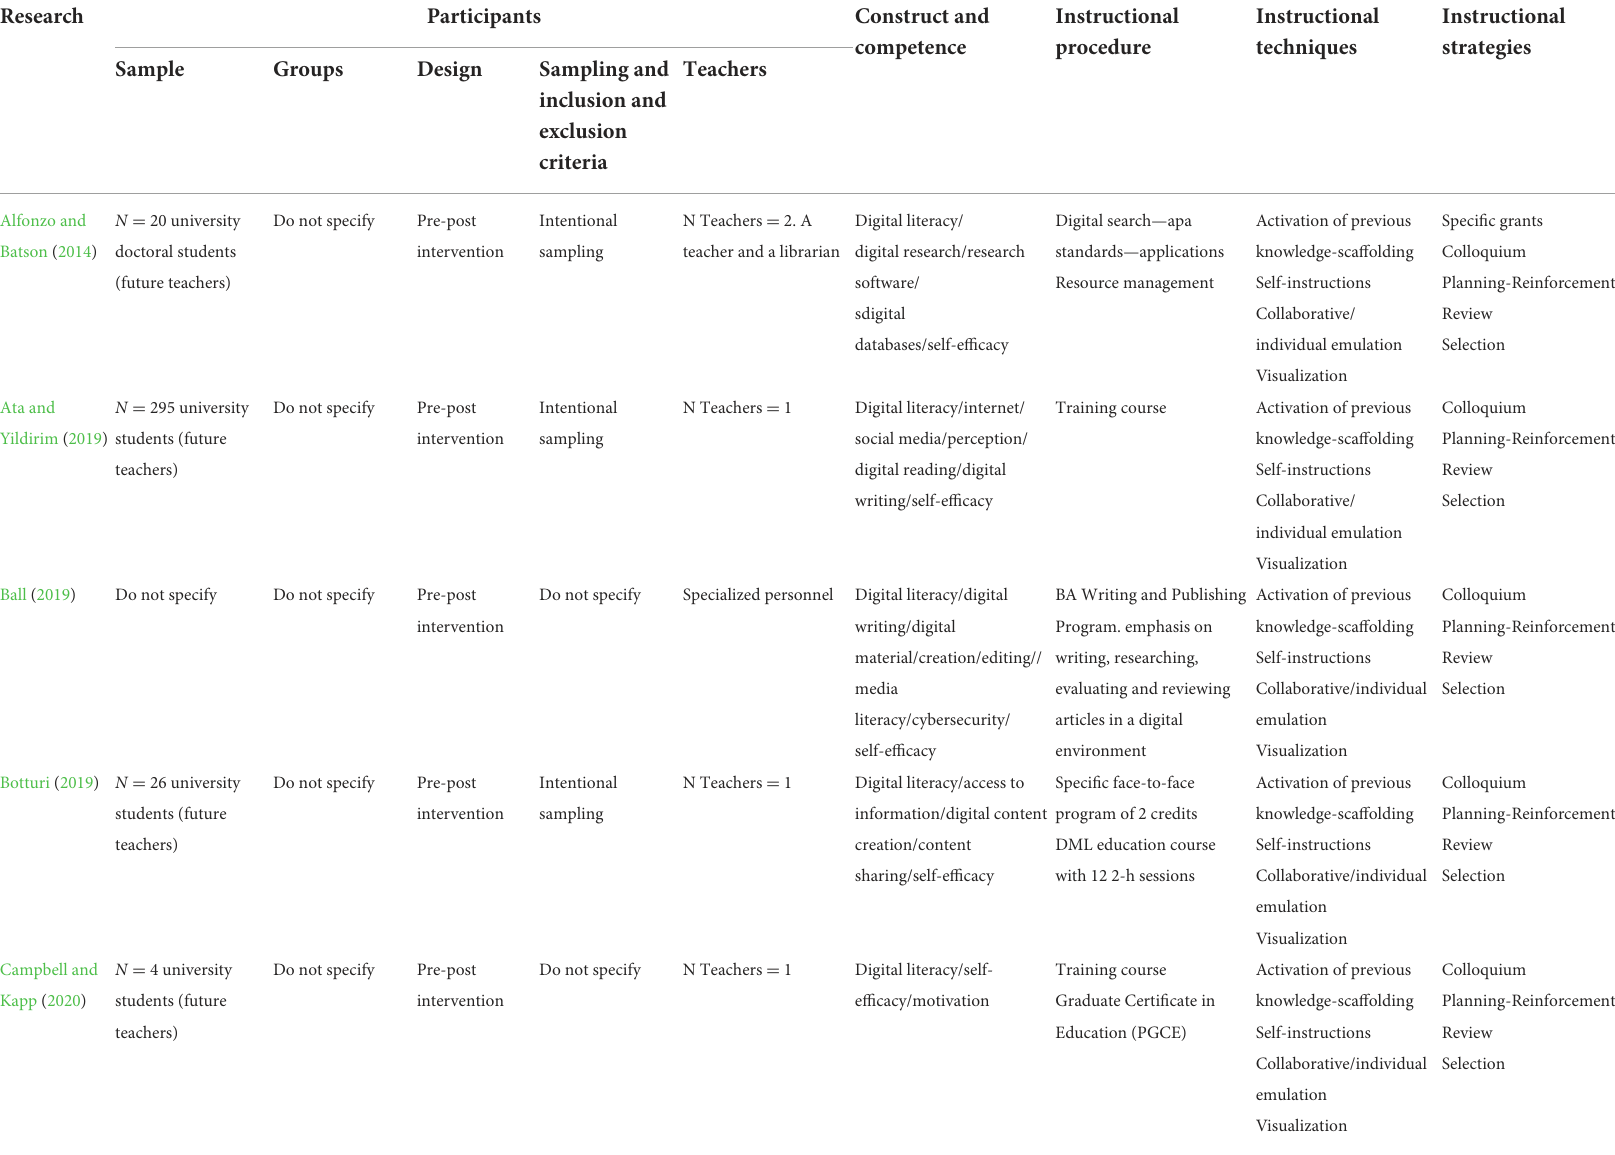
TABLE 1 Summary of the results